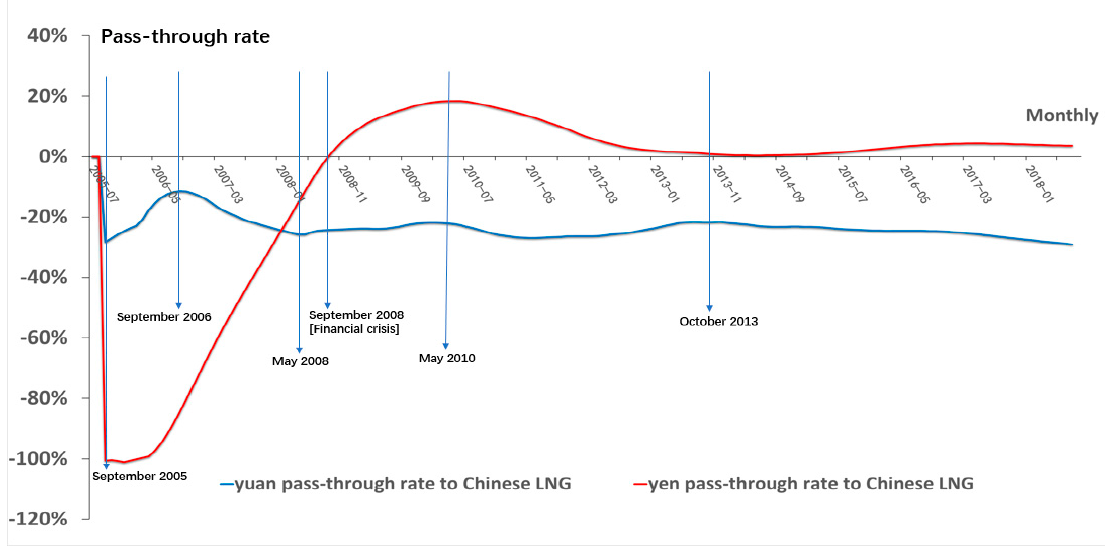
Figure 6. Changes in the pass-through rate for the CNY (E1 (cid:3047) , PL (cid:3047) ,PJ (cid:3047) ) and JPY (E2 (cid:3047) , PL (cid:3047) , PJ (cid:3047) ) .